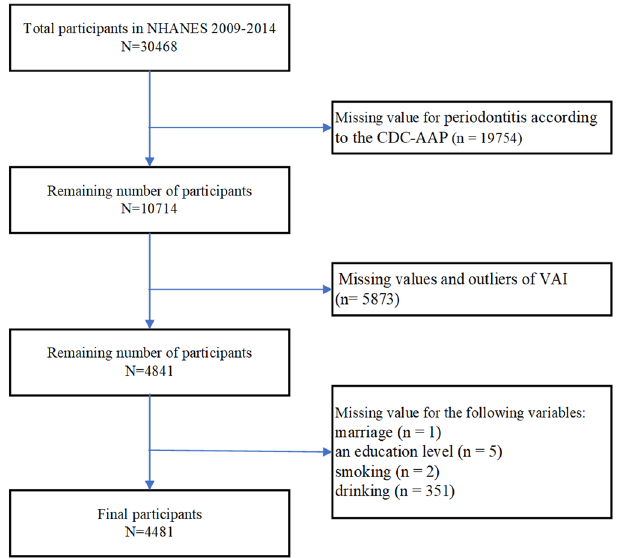
Figure 1. A flowchart of the participant selection process. VAI visceral adiposity index, CDC-AAP Centers for Disease Control and Prevention-American Academy of